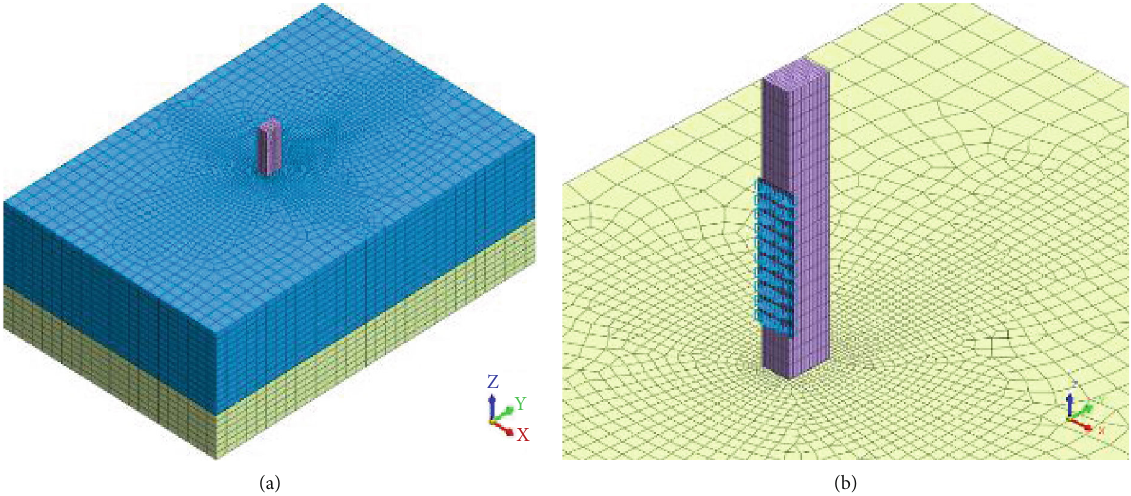
Figure 6: Schematic diagram of model